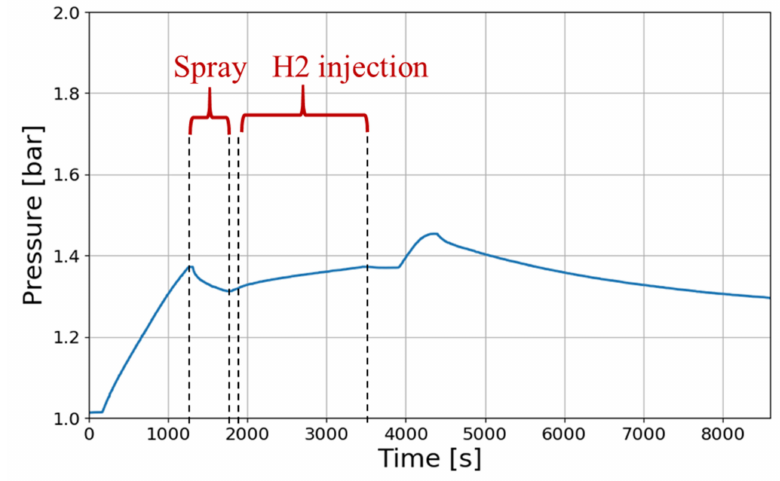
Figure 10. Time variation in the vessel pressure during the SSP3 test.